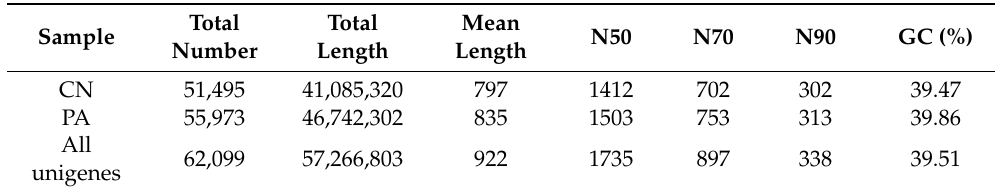
Table 2. Quality metrics of transcripts.